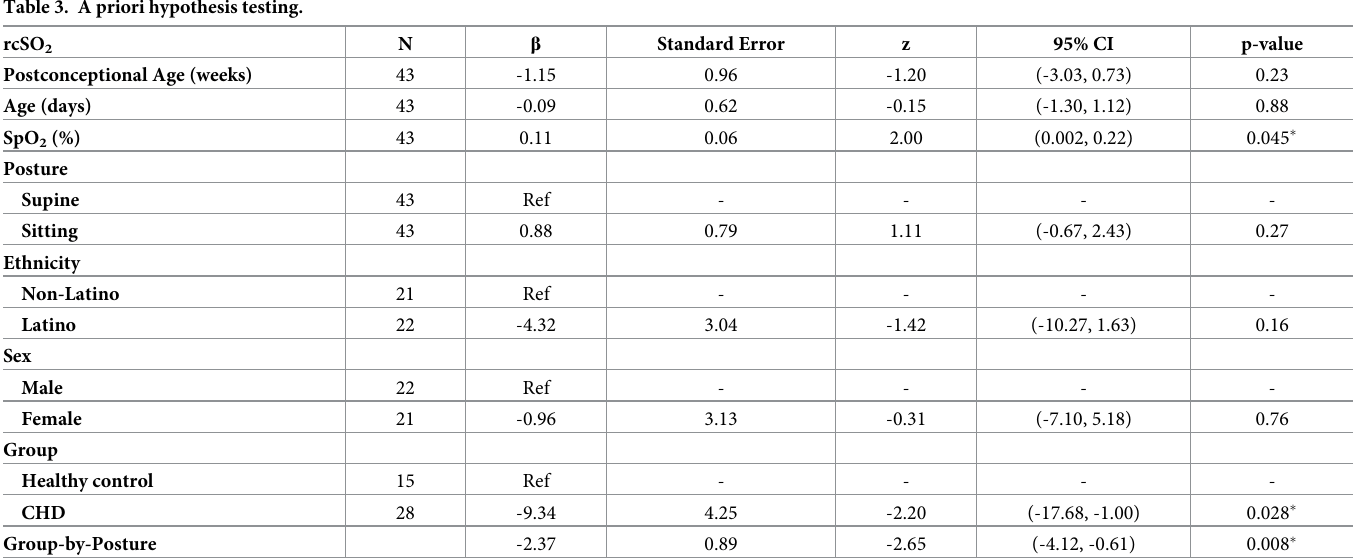
Table 3. A priori hypothesis testing.